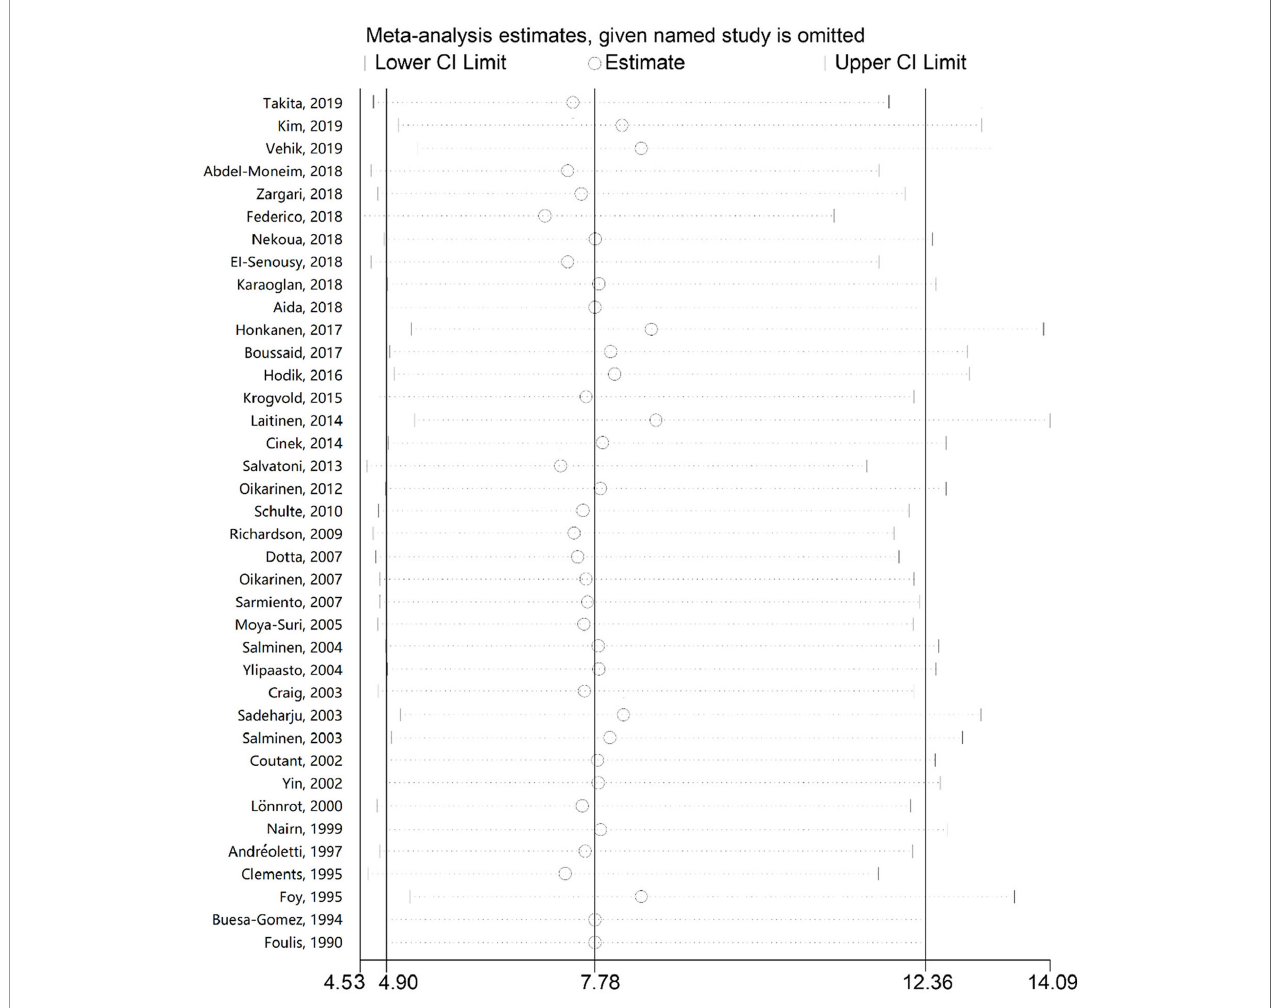
FIGURE 3 | Sensitivity analysis of the association between enterovirus and type 1 diabetes. The odds ratios and 95% con fi dence intervals (CIs) for the association between enterovirus and type 1 diabetes were recalculated by sequentially excluding each study indicated on the